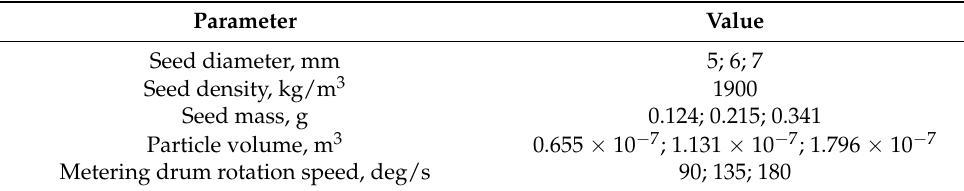
Table 5. Simulation parameters seed sowing